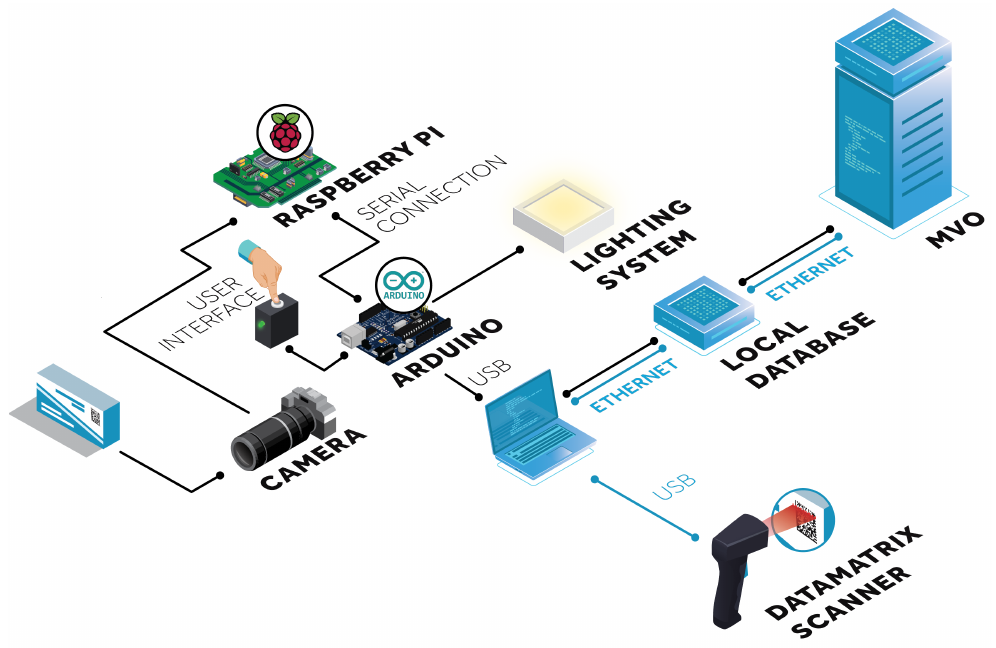
Figure 5. System architecture schematic. The current process is illustrated by the blue arrows while the proposed methodology is represented by the black ones. The connection from the MVO to the computer, in order to give visual feedback on the medicine packages, has not been implemented